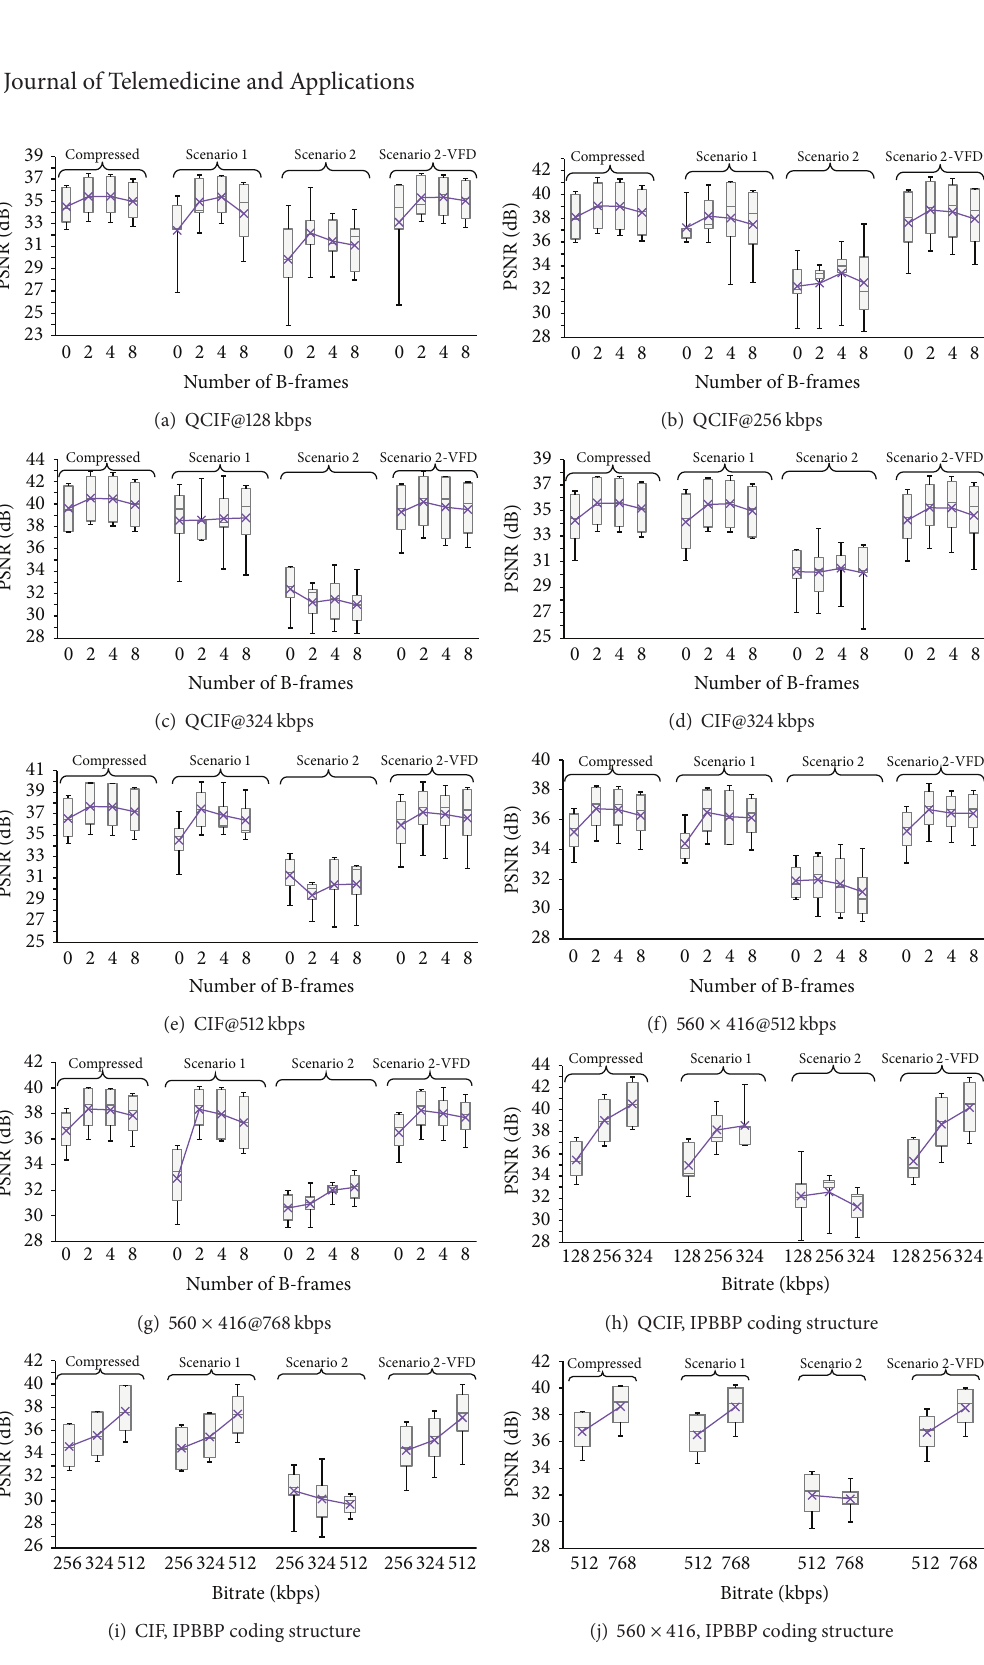
Figure 4: Box plots depicting the PSNR ratings for the five videos parting the examined dataset and the two investigated scenarios. Figures 4(a)–4(g) illustrate the objective scores for all coding structures, resolutions, and bitrates described in the experimental setup, while Figures 4(h)–4(j) summarize the results for the best performing IPBBP coding structure. Removal of temporal mismatch in the received video in scenario 2, using the VFD algorithm, results in high PSNR ratings, compared to that of scenario 1, and in accordance with the clinical evaluation (see Table